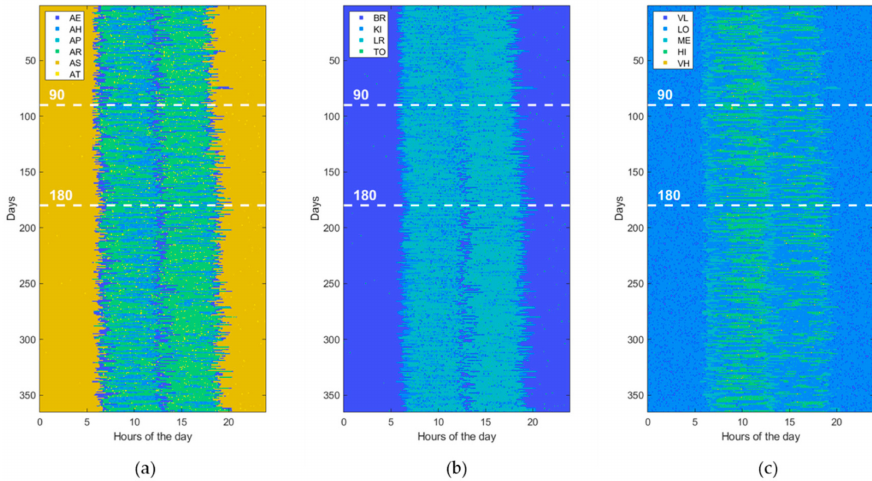
Figure 10. Example of an abnormal data set, due to a change in “Location of activity” (Lo). The change gradually takes place from the 90th day on. ( a ) ADL, ( b ) LOCs, and ( c )